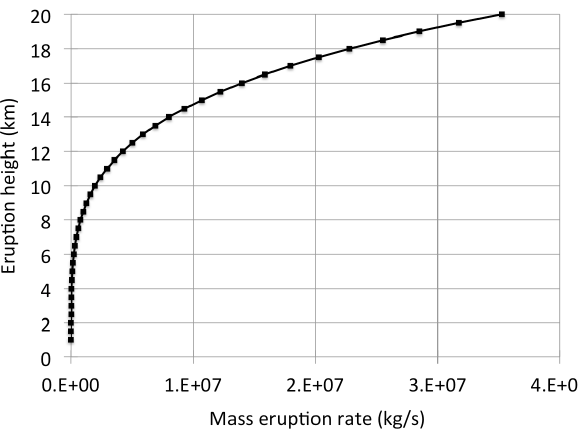
Fig. 3. Mean mass eruption rates derived from injection